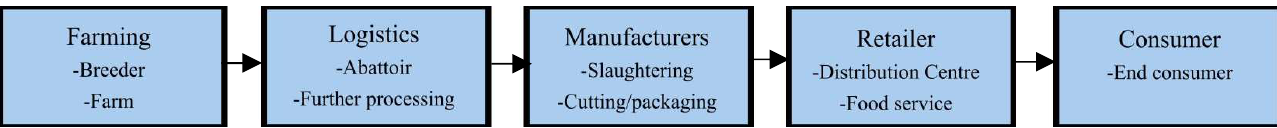
Figure 1. Beef supply chain stages (adopted from [18]).